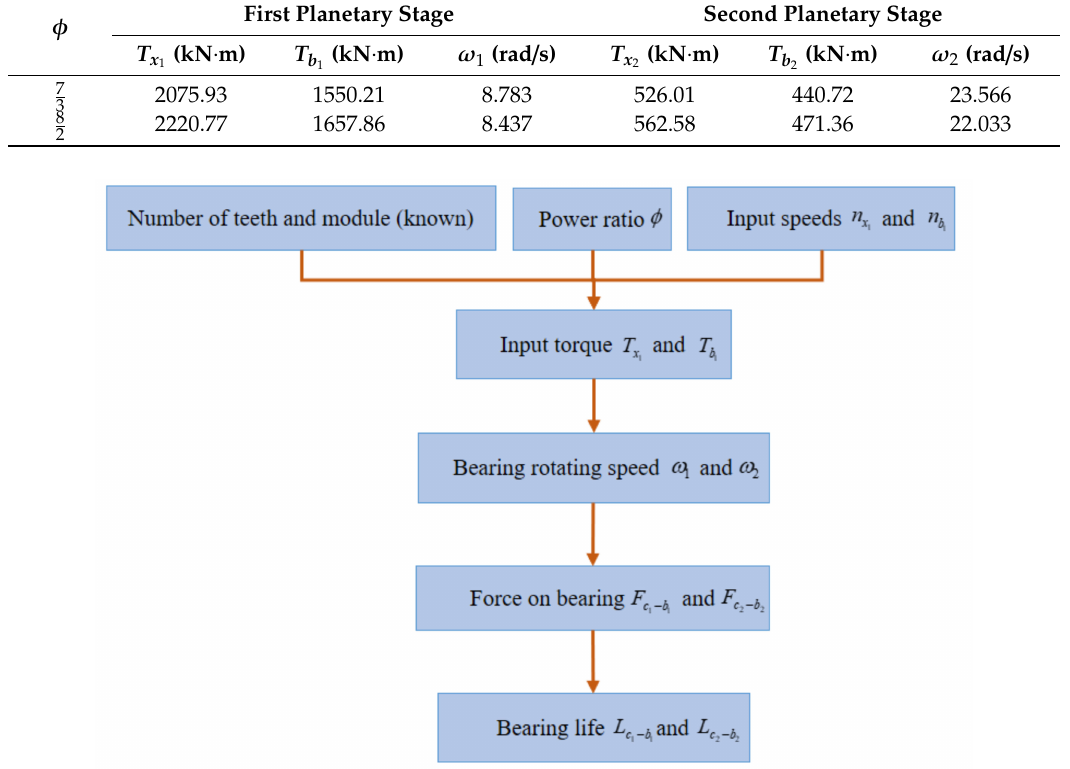
Figure 6. Calculation process of force and life of planet gear bearing.